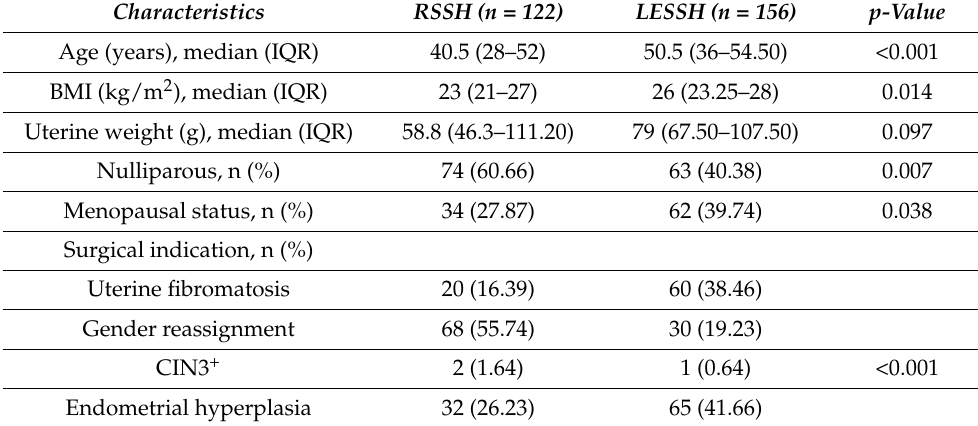
Table 1. Demographic characteristics of patients enrolled.